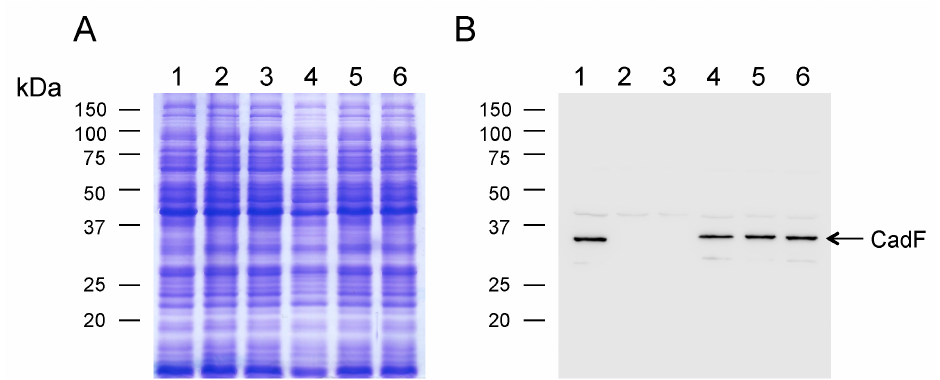
Figure 2. Electrophoretic and immunoblot analysis of C. jejuni ∆ cadF transformants. Bacterial whole-cell lysates were separated in SDS 12.5% polyacrylamide gels and either: ( A ) stained with Coomassie Brilliant Blue R-250 or ( B ) transferred to polyvinylidene fluoride membranes and probed with a rabbit α -CadF serum. The positive control consisted of a C. jejuni wild-type strain, and the negative controls consisted of a mutant with a cadF gene deletion ( ∆ cadF ) and a mutant with a promoterless cadF gene fused to a FLAG-tag ( ∆ cadF :: cadF NP -FLAG). The arrow indicates the CadF protein. Lanes: C. jejuni strains (1) 81-176 (wild-type); (2) ∆ cadF ; (3) ∆ cadF :: cadF NP -FLAG; (4) ∆ cadF :: P cadF -283 bp cadF -FLAG; (5) ∆ cadF :: P cadF -334 bp cadF -FLAG; and (6) ∆ cadF :: P cadF -400 bp cadF -FLAG. Molecular mass standards (in kDa) are on the left.